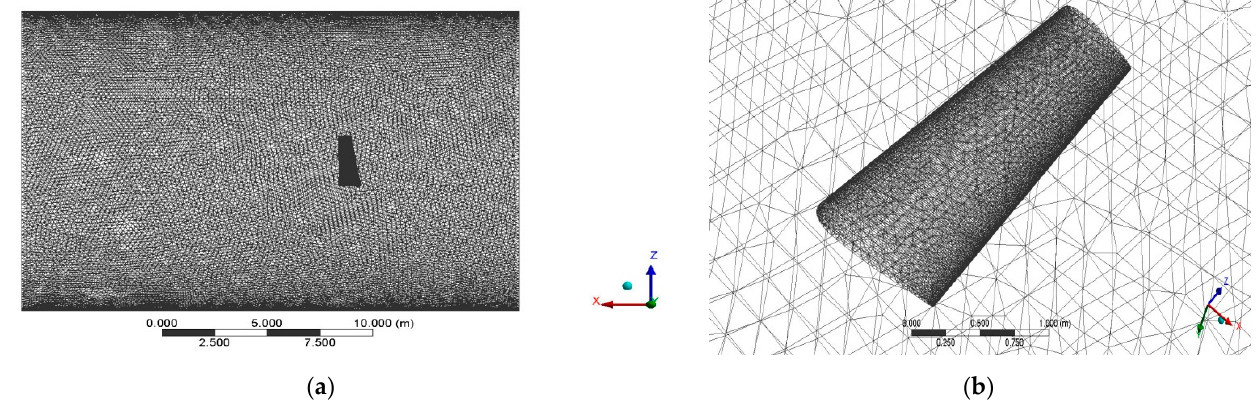
Figure 9. Discretized structure of a small UAV’s wing for CFD investigations. ( a ) A typical top view of entire discretized structure. ( b ) A typical zoomed view of discretized structure of UAV’s wing.